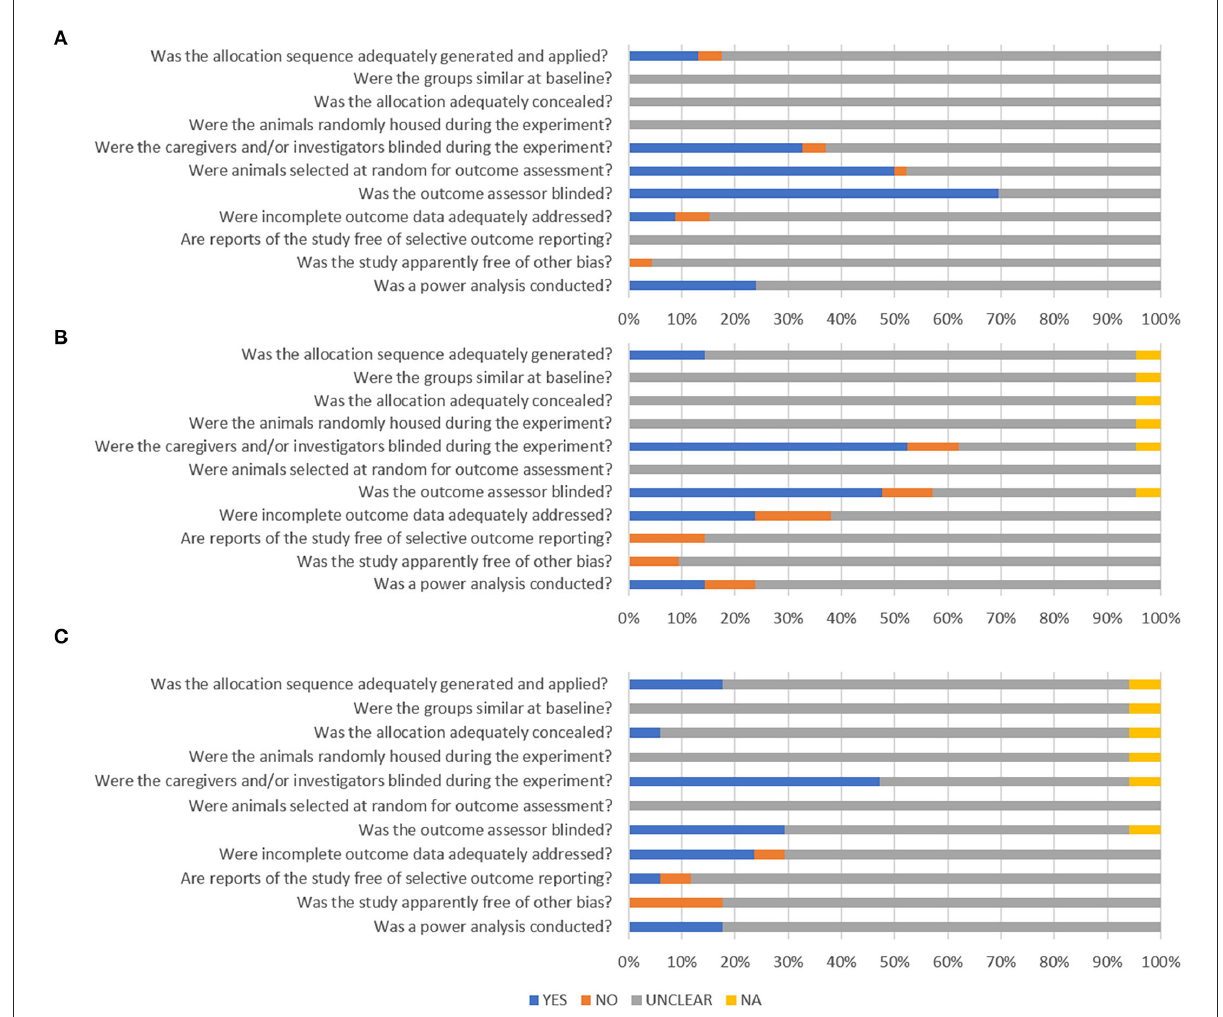
FIGURE6 Risk of bias assessment for grimace scale (A) , nest building (B) , and burrowing (C) . Mice and rats were pooled together per pain parameter. YES, scored a low risk of bias; NO, scored a high risk of bias; UNCLEAR, scored an unclear risk of bias; NA, not applicable; RoB item was not applicable as only one group was used in the